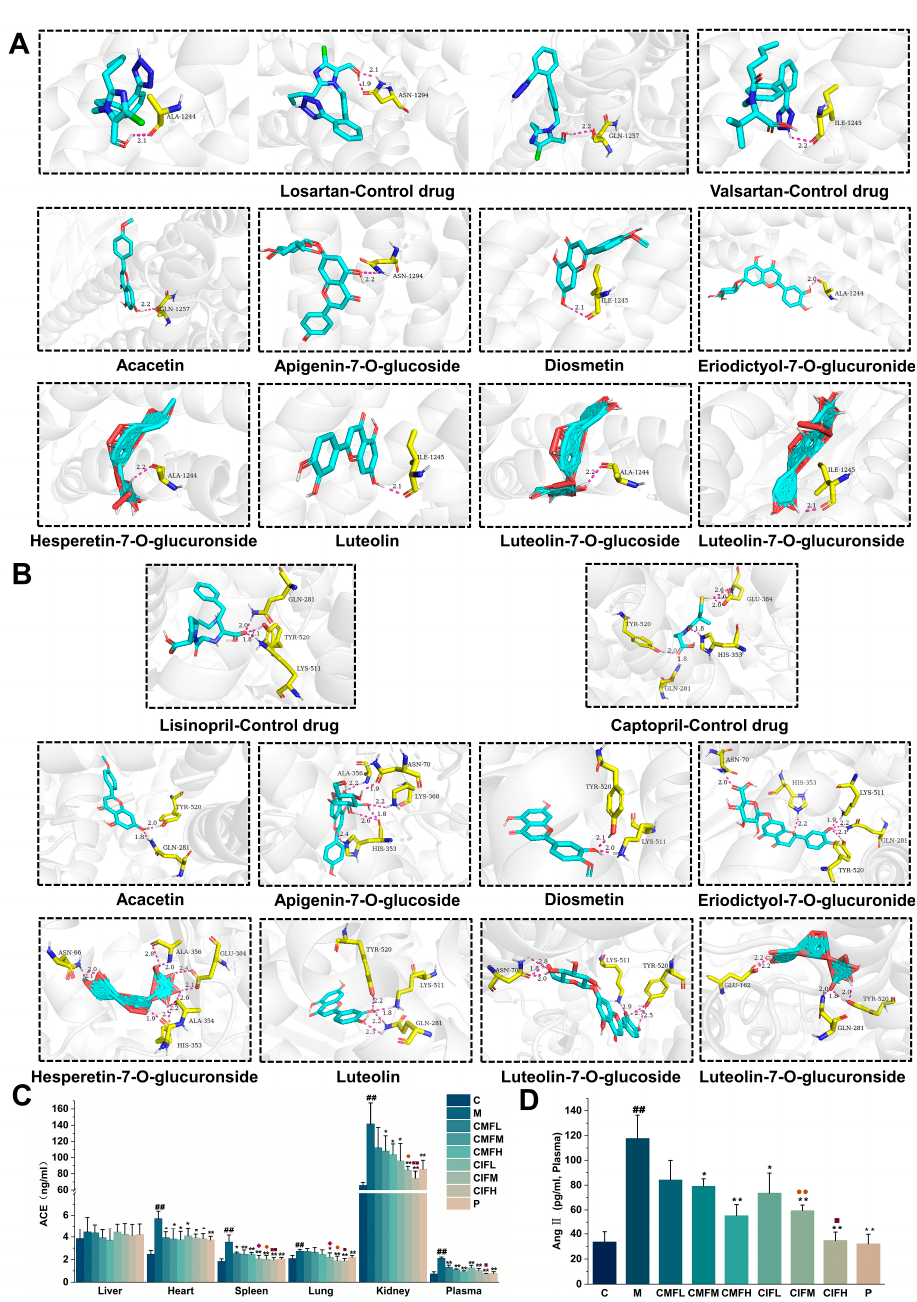
Figure 8. The abilities of CMF and CIF in regulating RAS. ( A , B )—Molecular docking interaction diagrams of active compounds with 6OS2 and 1O86, respectively; ( C )—ACE activity in tissues and plasma; ( D )—Ang II viability in plasma. Values shown are means ˘ SD. ## p < 0.01 compared with C group; * p < 0.05, ** p < 0.01 compared with M group; ˛ p < 0.05compared with CMFL group; ‚ p < 0.05, ‚‚ p < 0.01 compared with CMFM group; (cid:4) p < 0.05, (cid:4)(cid:4) p < 0.01 compared with CMFH